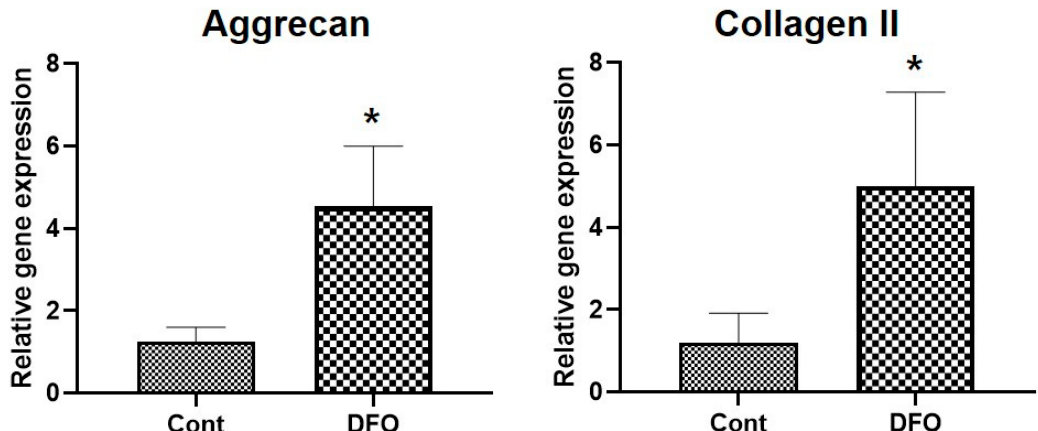
Figure 1. Hypoxia increases mRNA expression of Aggrecan and Collagen II in nucleus pulposus (NP) cells. The mRNA levels of Aggrecan and Collagen II in NP cells treated with DMSO or Deferoxamine (150 µM) were analyzed by qRT–PCR. β -Actin was used as a normalizer. Error bars represent mean ± SD. * p < 0.05 (n = 6).